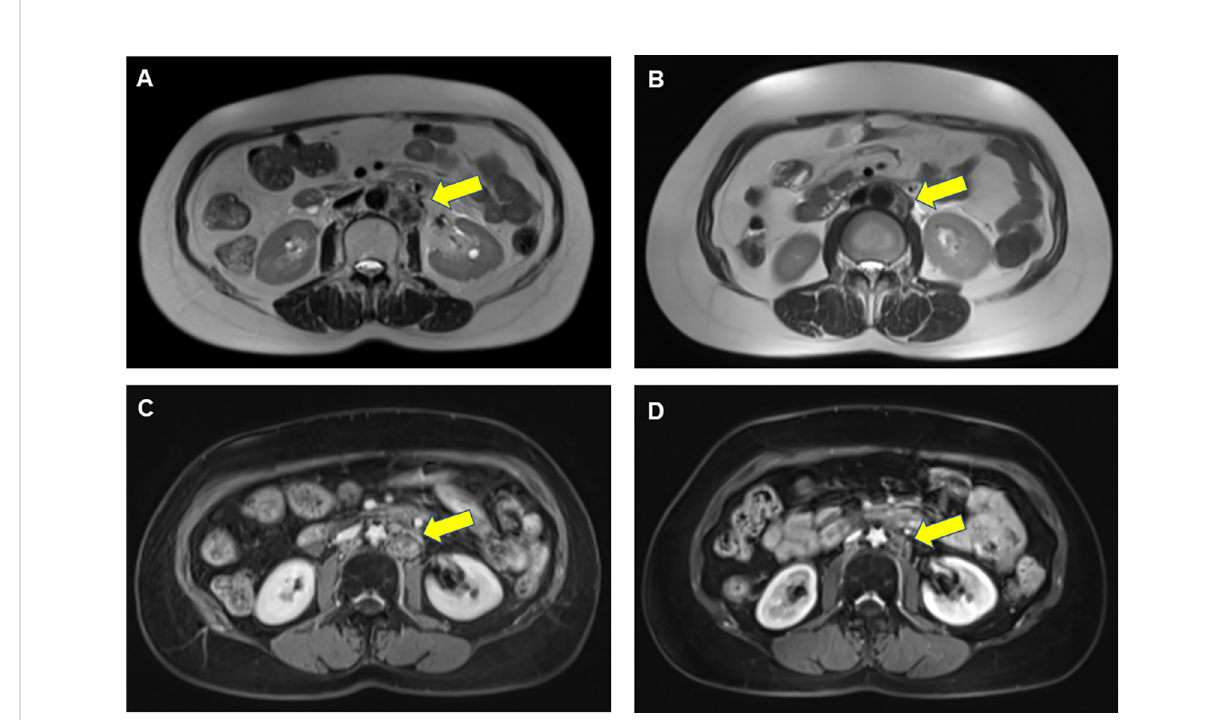
FIGURE 2 Results of abdominal MRI scans before and after ICI rechallenge treatment in a patient with endometrial cancer. Prior to PD-1 rechallenge, T2- weighted image (A) and T1-weighted enhanced scans (C) showed enlarged lymph nodes visible next to the abdominal aorta. After 2 cycles of PD-1 rechallenge, T2-weighted image (B) and T1-weighted enhanced sequence (D) indicated that those lymph nodes achieved partial remission. The yellow arrow represented tumor